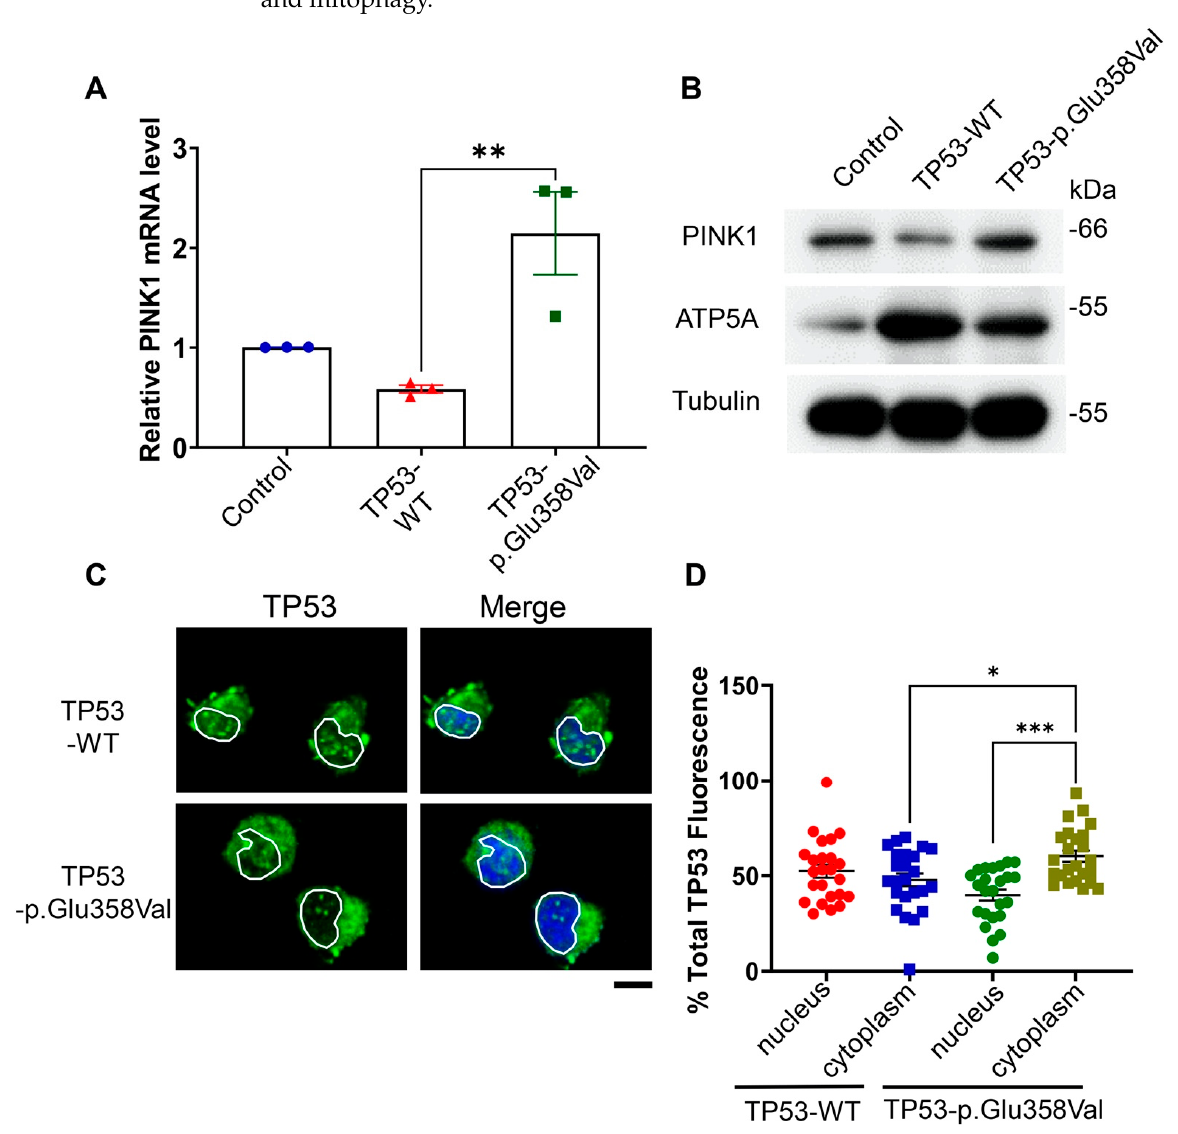
Figure 6. Wild-type TP53, but not TP53-p.Glu358Val, suppresses mitophagy by reducing PINK1 levels. ( A ) PINK1 mRNA levels. ( B ) Immunoblots of PINK1, ATP5A and tubulin protein levels. ( C ) Subcellular localization of TP53 in H2172 cells. DAPI is used to indicate the position of nucleus. Scale bar = 10 µm. ( D ) Quantification of TP53 fluorescence intensity in nucleus vs. cytoplasm. * p < 0.05, ** p < 0.01, *** p < 0.001.